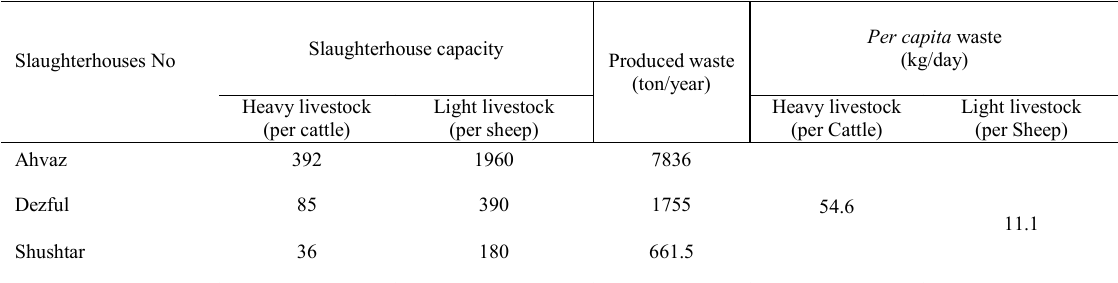
Table 1: Characteristics of study cattle